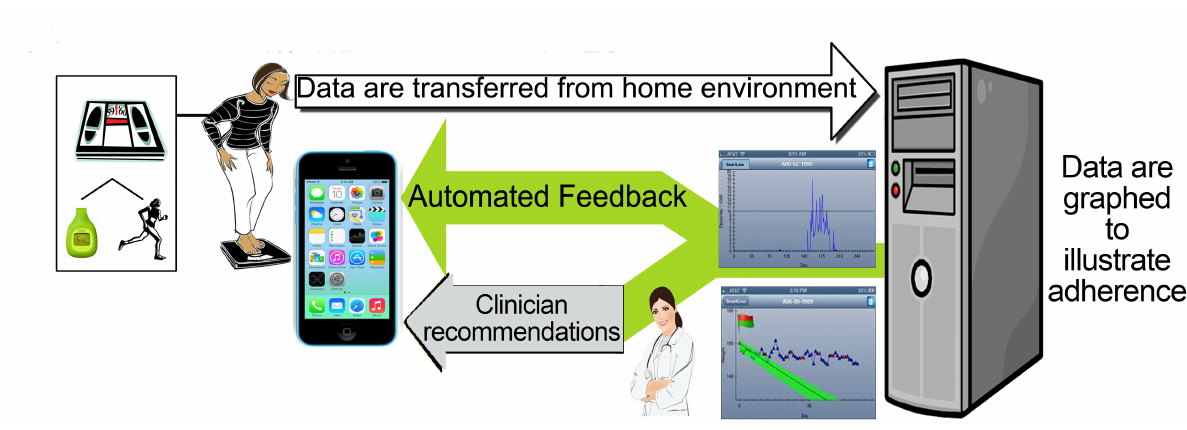
Figure 3. The overall concept of the SmartLoss Virtual Weight Management Suite: objective weight and exercise data are obtained, those data are integrated into personalized behavioral goals, and both automated and customized feedback based on client data and their relation to preestablished goals are transmitted to the client.